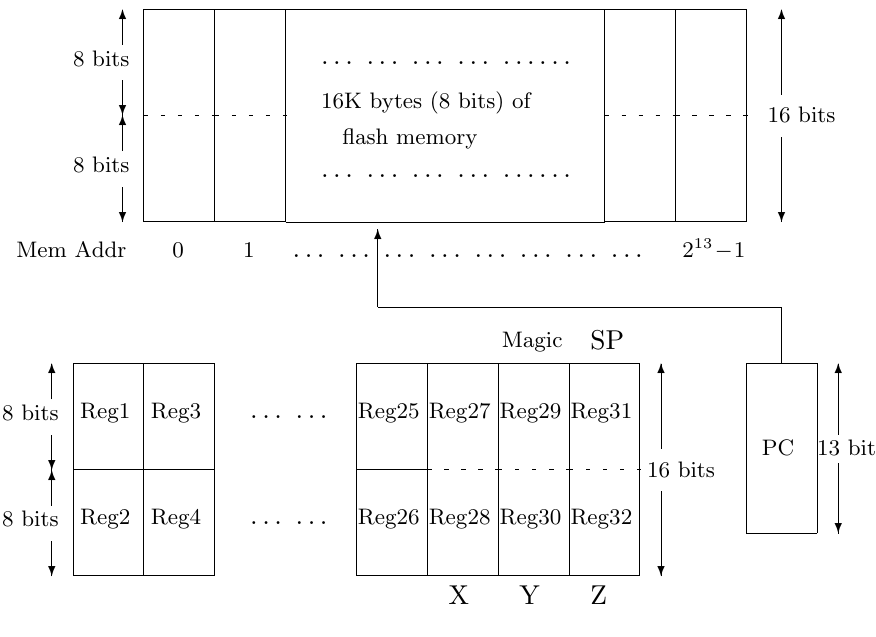
Figure 2: An architectural overview of